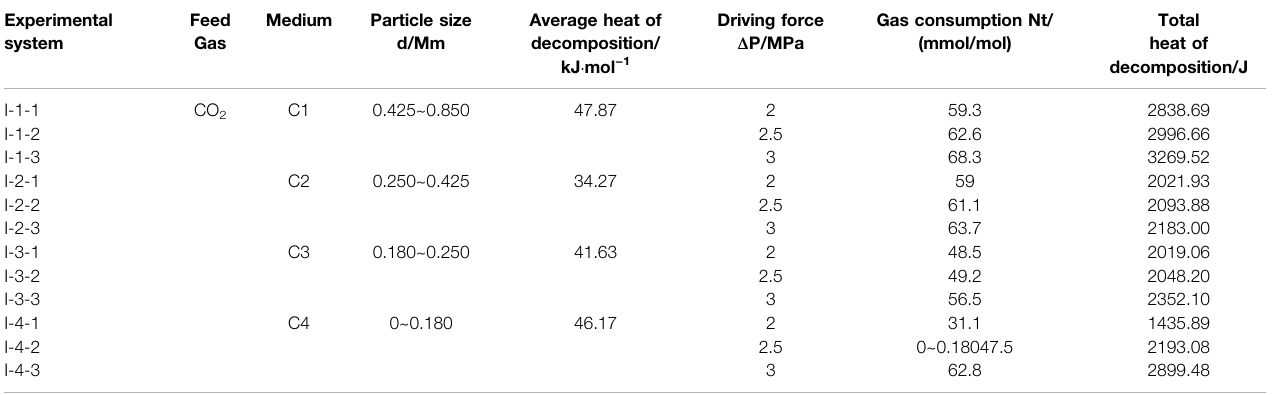
TABLE 4 | Total heat of decomposition of CO 2 hydrates in coal particles under the different driving forces. Experimental system